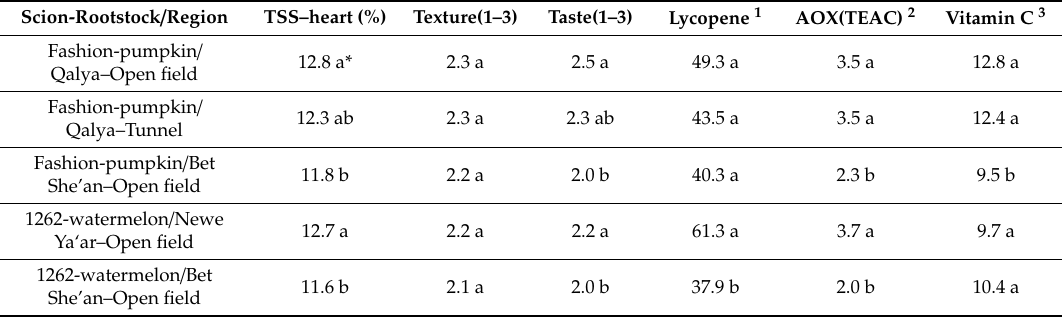
Table 3. Comparison among growing localities in relation to fruit quality parameters evaluated after 4 days at 21 ◦ C. Means were analyzed separately for each growing region. The quality parameters for all the grafted treatments were compiled and analyzed by one-way